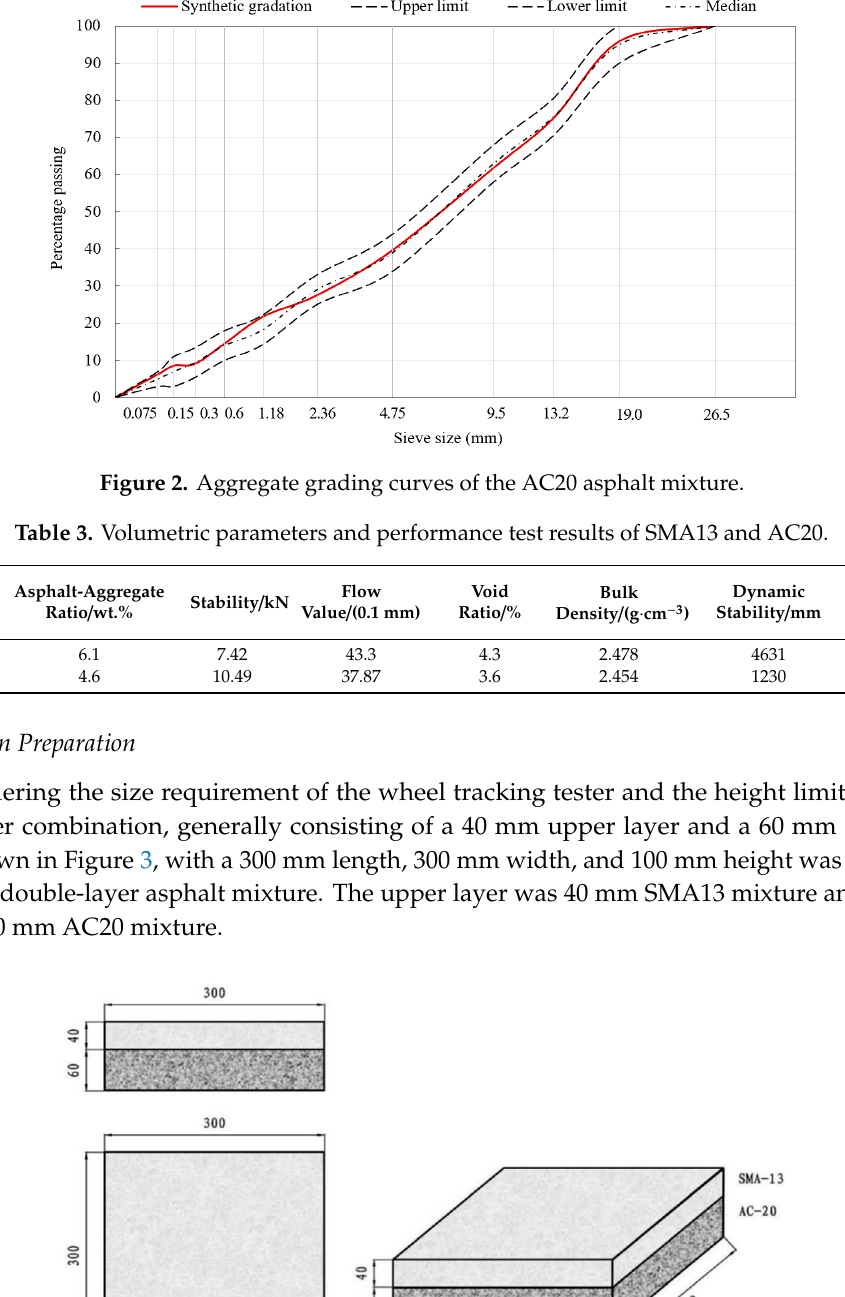
Figure 3. The size of the mold for the wheel tracking test specimen (mm).